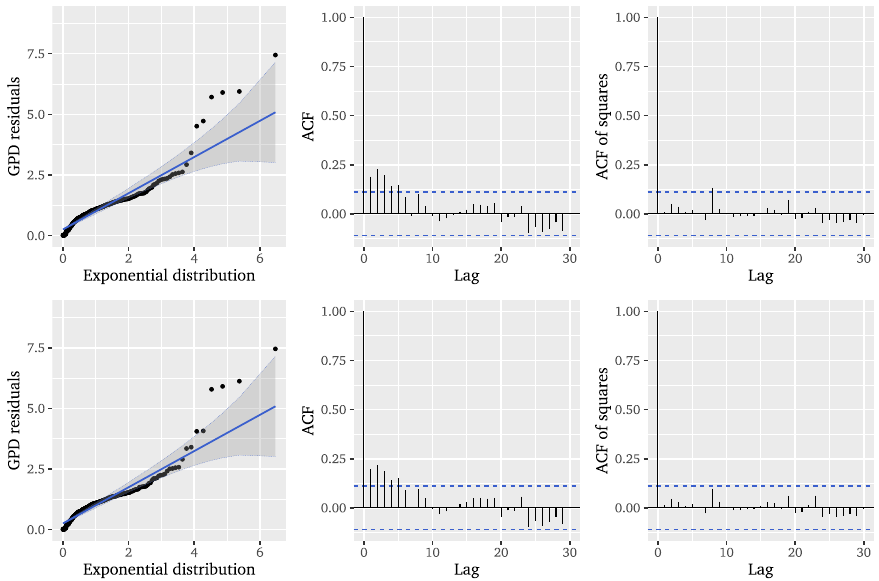
Figure A2. Unit exponential QQ plot and autocorrelation functions for the GPD residuals of the SEPOT model (with ETAS and exponential decay).